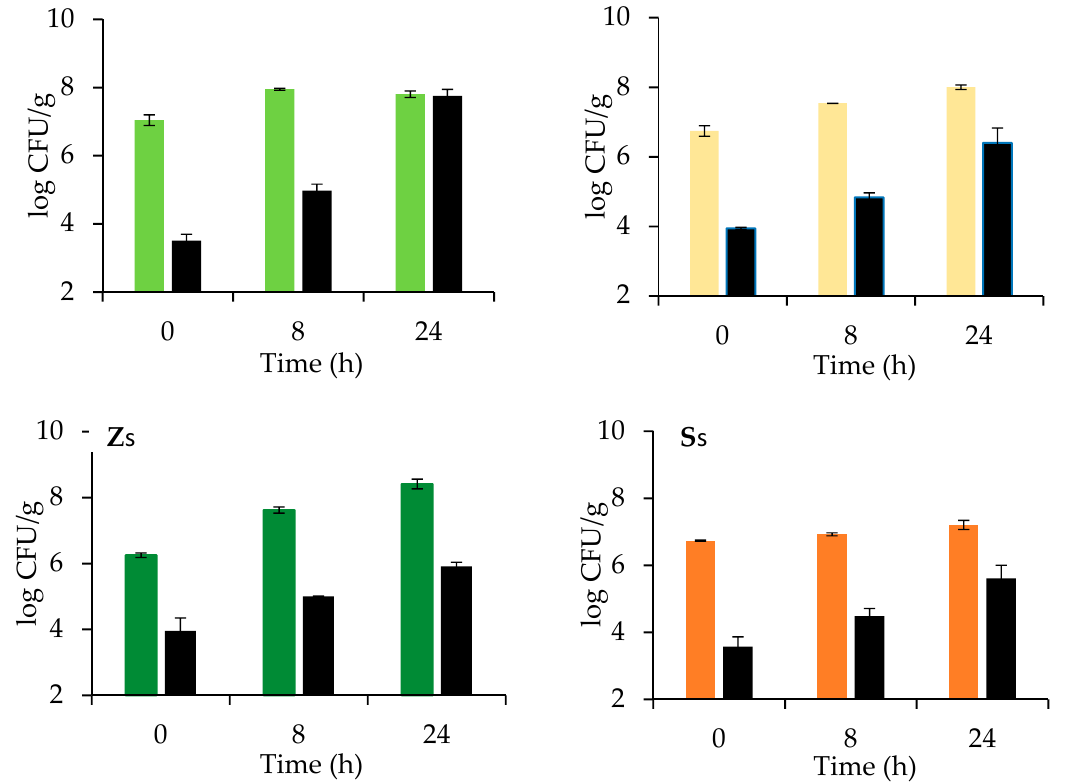
Figure 2. Microbial counts of Z. mobilis (green), S. cerevisiae (orange) and total bacteria (black) after 0, 8, and 24 h of leavening at 26 °C of doughs fermented by Z. mobilis (Z, light green) or S. cerevisiae (S, light orange) without and with sucrose (Zs and Ss respectively, green and orange) addition (average values of two technological replicates; error bars represent standard deviation values). See Table 1 for sample identifications and formulations.